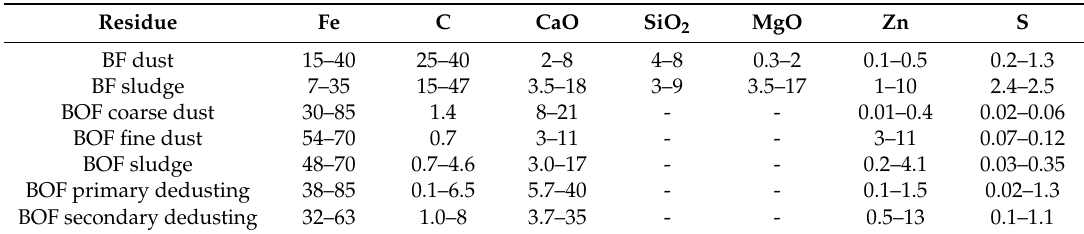
Table 1. Typical composition in wt.% of selected off-gas dusts from the blast furnace (BF) and basic oxygen furnace (BOF)